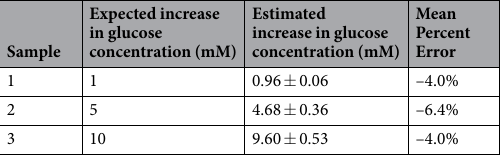
Table 2. Detection of increase in glucose concentration in mouse blood